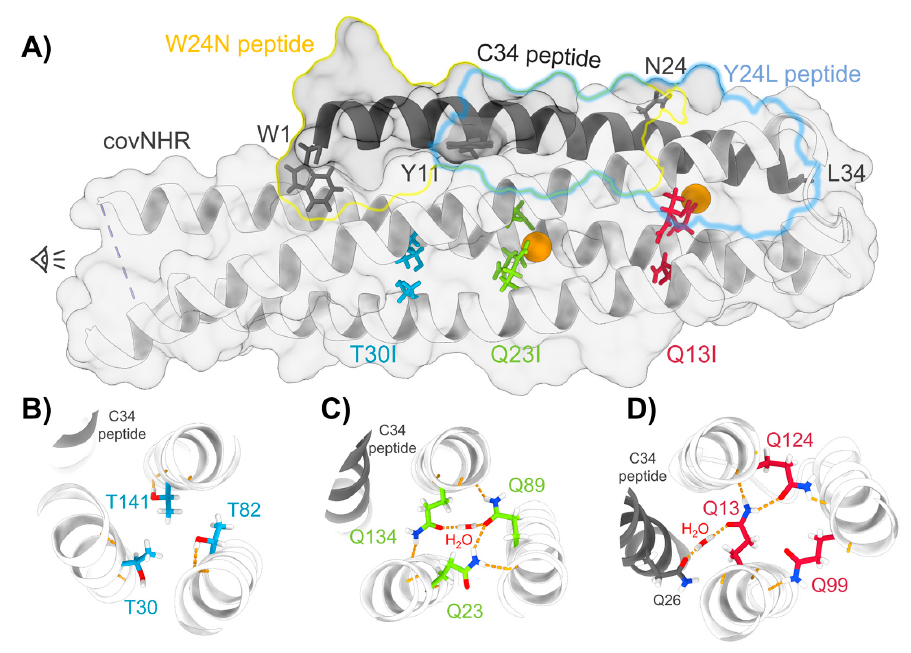
Figure 1. Buried polar amino acids in the coiled-coil structure of covNHR. ( A ) Representation of the X-ray structure of the complex of covNHR with W34L (C34) (PDB id. 6R2G) [23]. The limits of the W24N and Y24L peptides are highlighted on the structure with yellow and blue lines, respectively. The buried polar side chains are represented with sticks and buried water molecules with orange spheres. ( B – D ) Cross-sectional representations of each triad of polar side chains showing hydrogen bonds in dashed yellow lines.